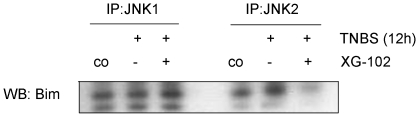
JNK2-Bim co-precipitation.JNK1 and JNK2 immunoprecipitates (IP) from colon tissue homogenates were analyzed by Western blotting with an anti-Bim antibody. Pounceau staining demonstrated equal loading (data not shown).